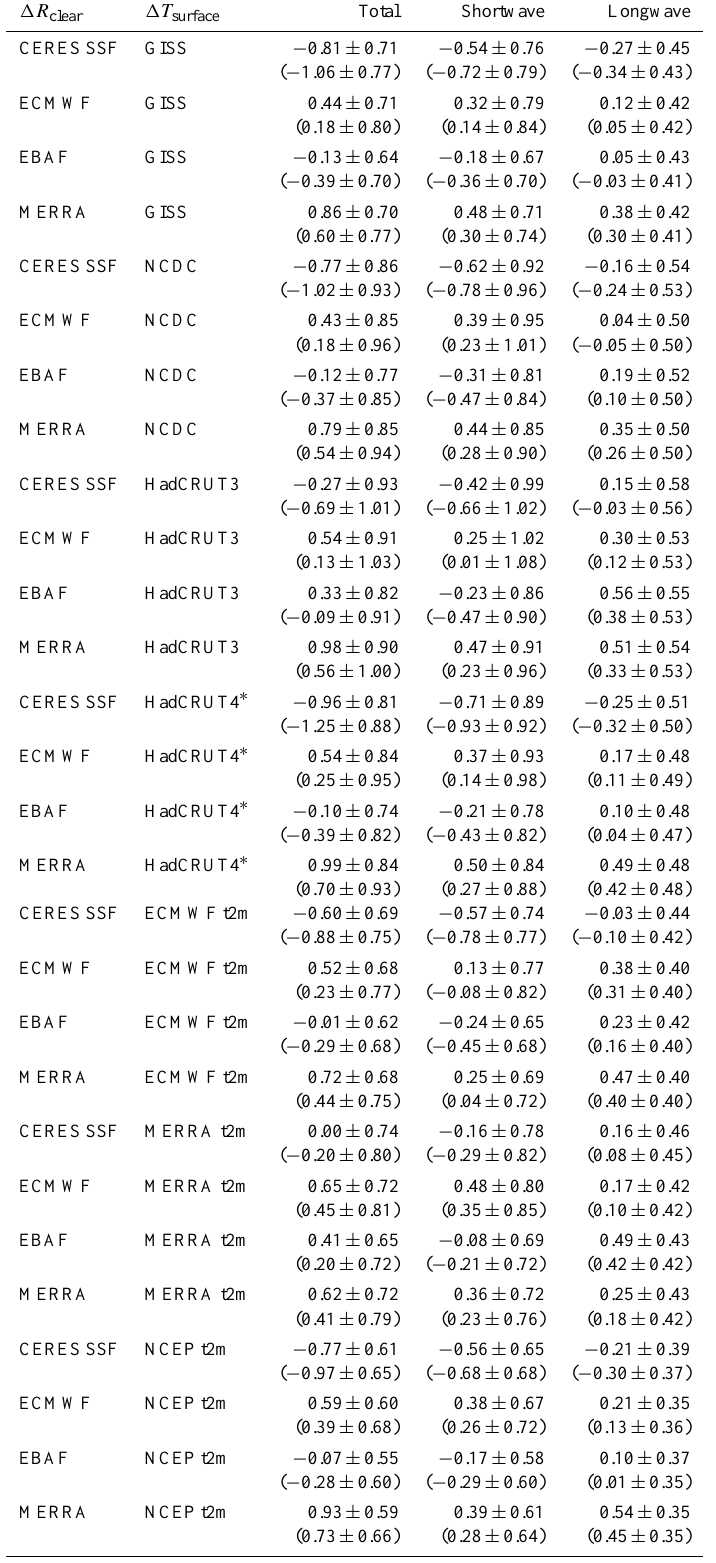
Table 3. Extended sensitivity tests. As in Table 1, but with additional temperature and clear-sky flux datasets, and only using monthly